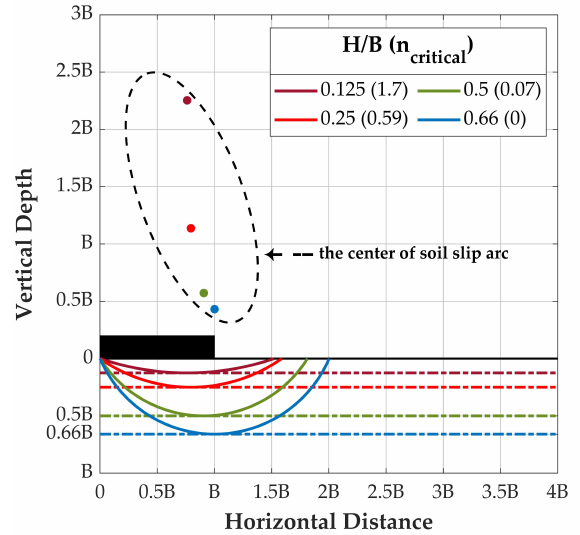
Figure 13. Required relative strength n critical of various H / B for soil